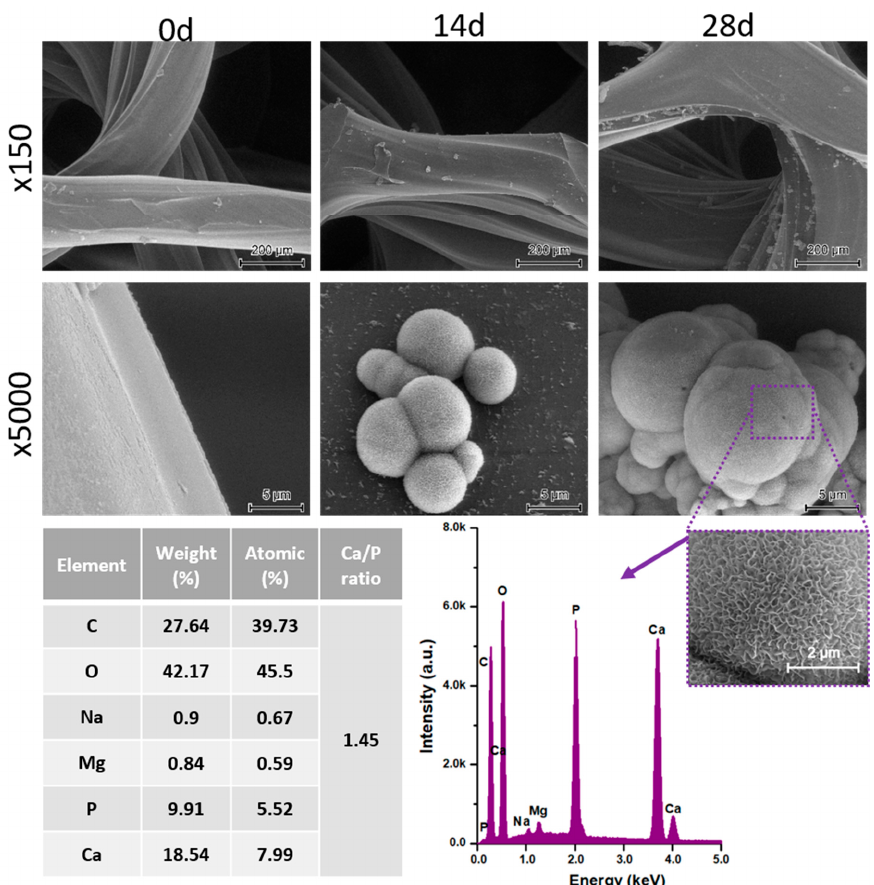
Figure 9. SEM images and EDS spectrum of G25 PTS after incubation in SBF.